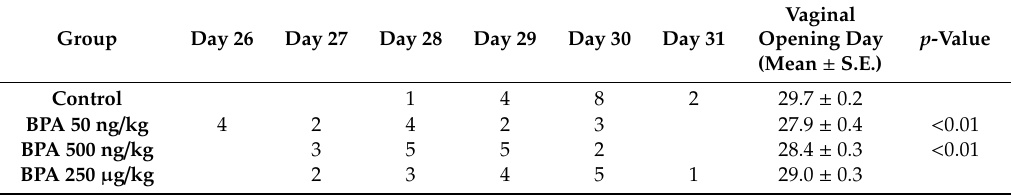
Table 1. The e ff ect of in utero exposure to BPA on vaginal opening dates.